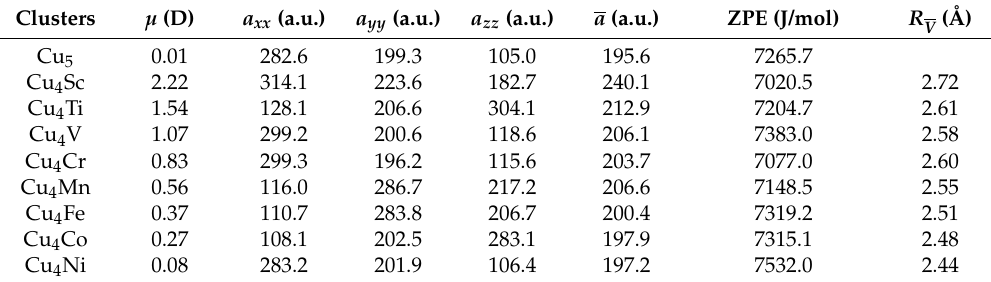
Table 3. The dipole moment ( µ ), polarizability ( a xx , a yy , a zz , a ) and zero-point energy (ZPE) of the most stable Cu 5 and Cu n M (M = Sc-Ni) clusters and average coordination bond length ( R